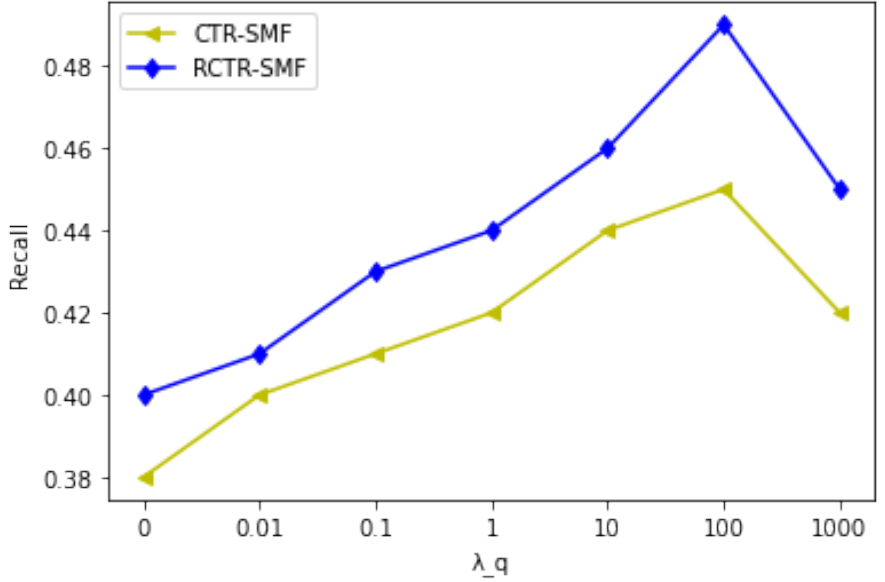
Figure 6. Recall Comparison of CTR–SMF and RCTR–SMF when λ q is varied, but λ v and λ r are kept constant @ M = 300. Table 6. Recall Comparison of RCTR and RCTR–SMF.